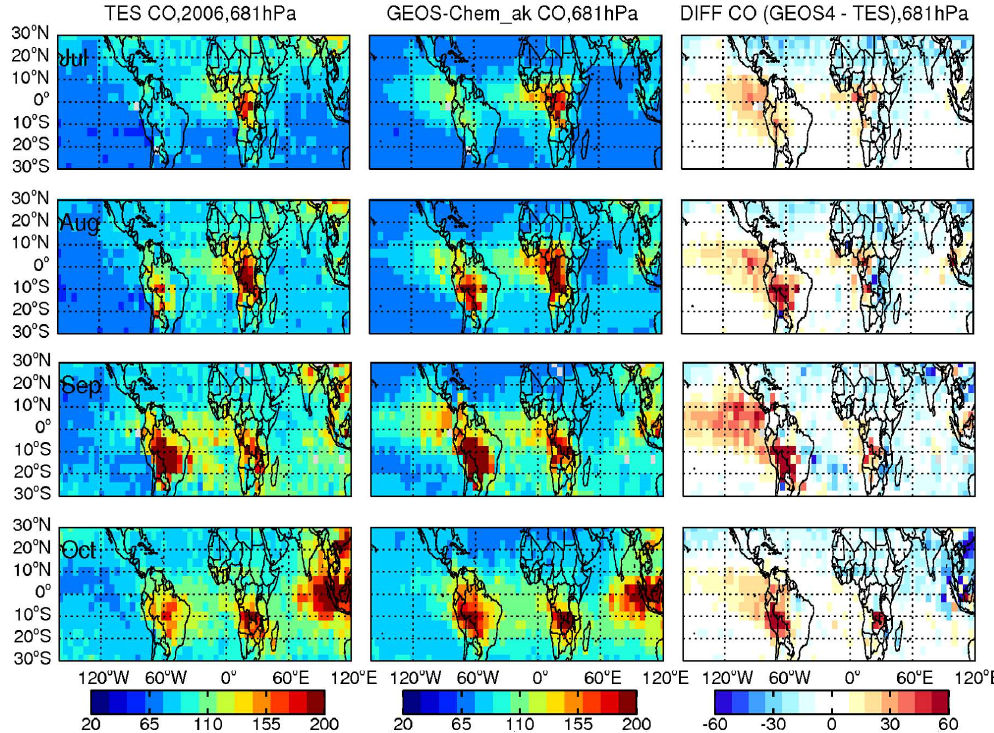
Fig. 15. Lower tropospheric CO at 681hPa from July to October 2006 from TES (left), the GEOS-4 simulation with modified emissions with the TES AKs applied (center), and the difference (modified model wAK–TES)